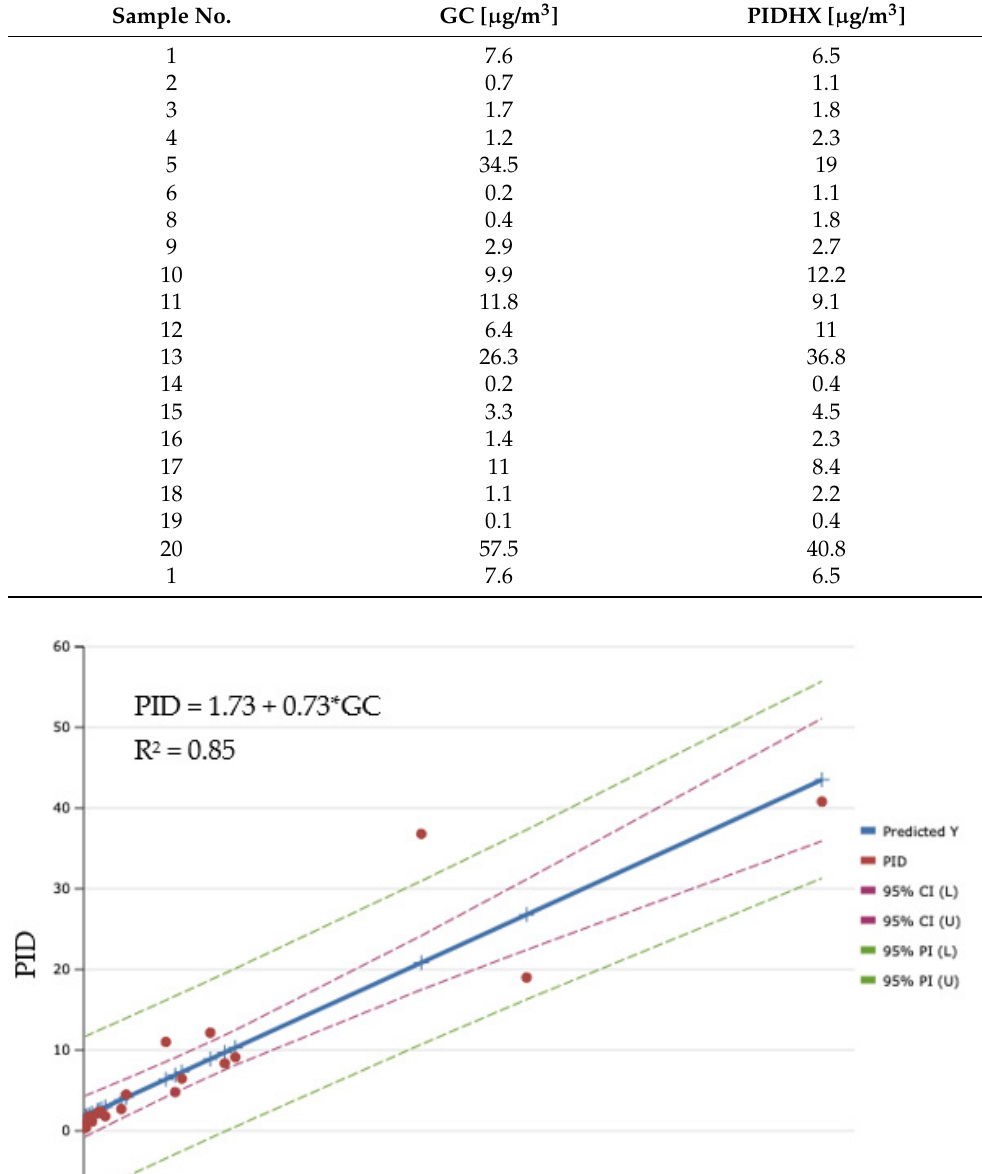
Table 8. Comparison of concentrations benzene determined by GC and PID response. Sample No.